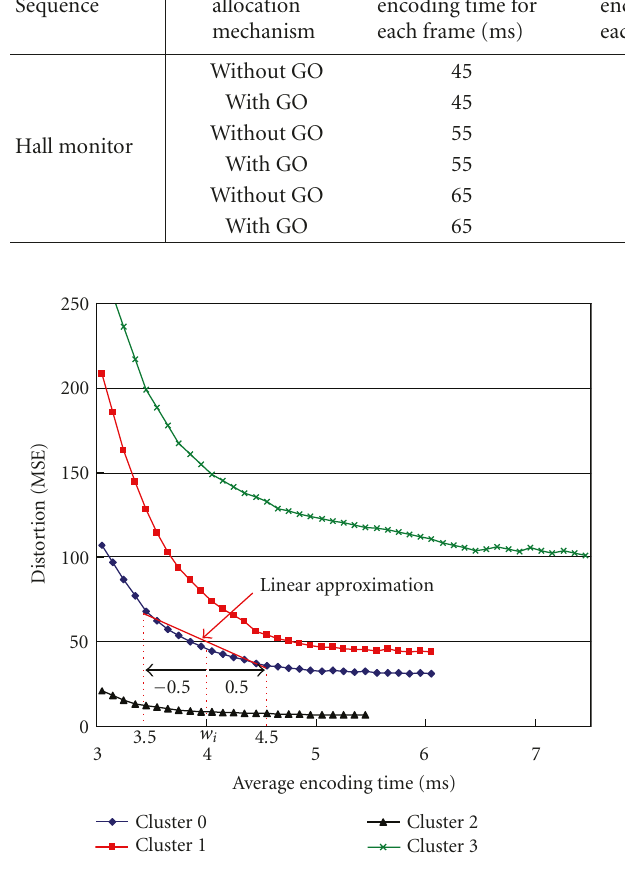
Figure 14: Piecewise linear approximation of the distortion func- tion.